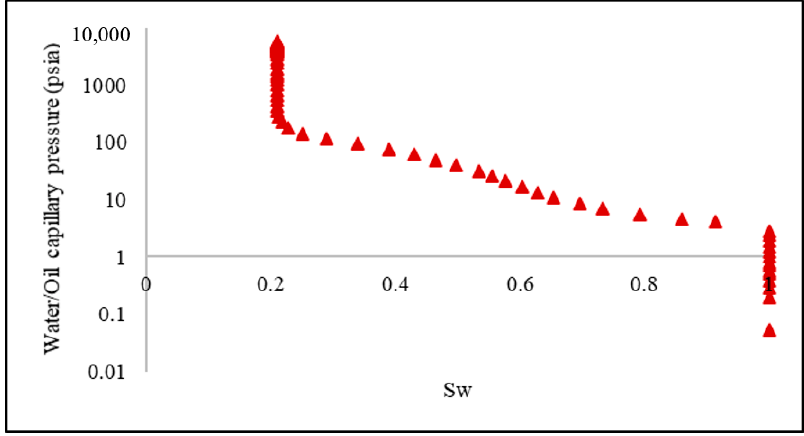
Figure 7. Copper Ridge dolomite water–oil capillary pressure curve.